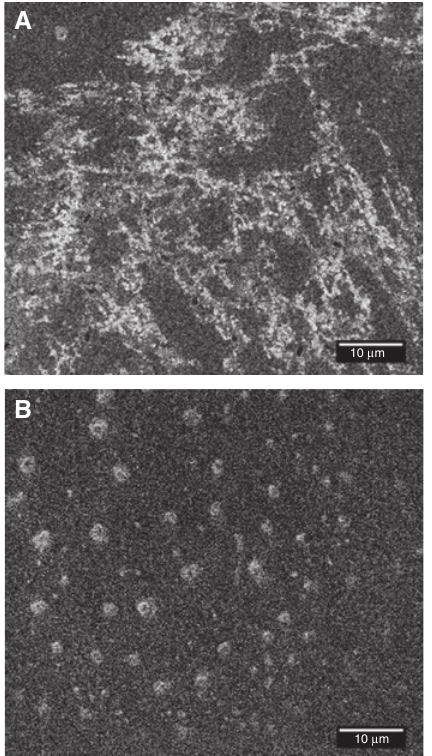
Figure 4: Scanning electron micrographs of (A) polypyrrole and (B) polypyrrole/PSS after 10 cyclic voltammetry scans in a solution of